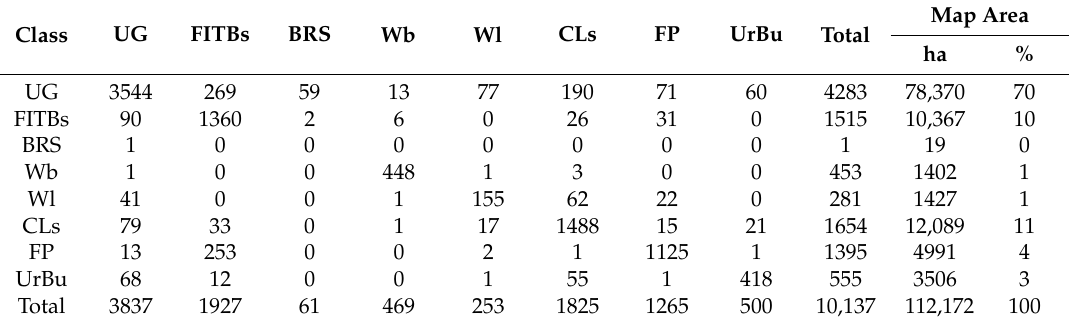
Table 4. Summarized accuracy assessment of LC map ENLC 2000 (T1) based on sample counts.